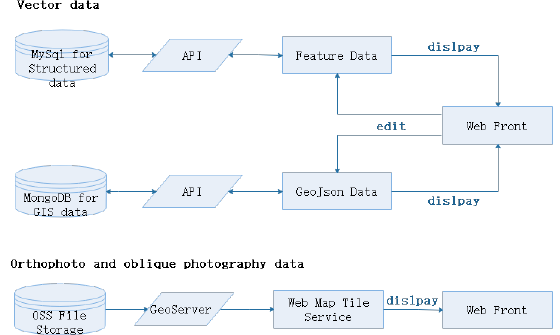
Figure 9 . Data Flows of Vector Data, Orthophoto and Oblique Photogrammetry Models.